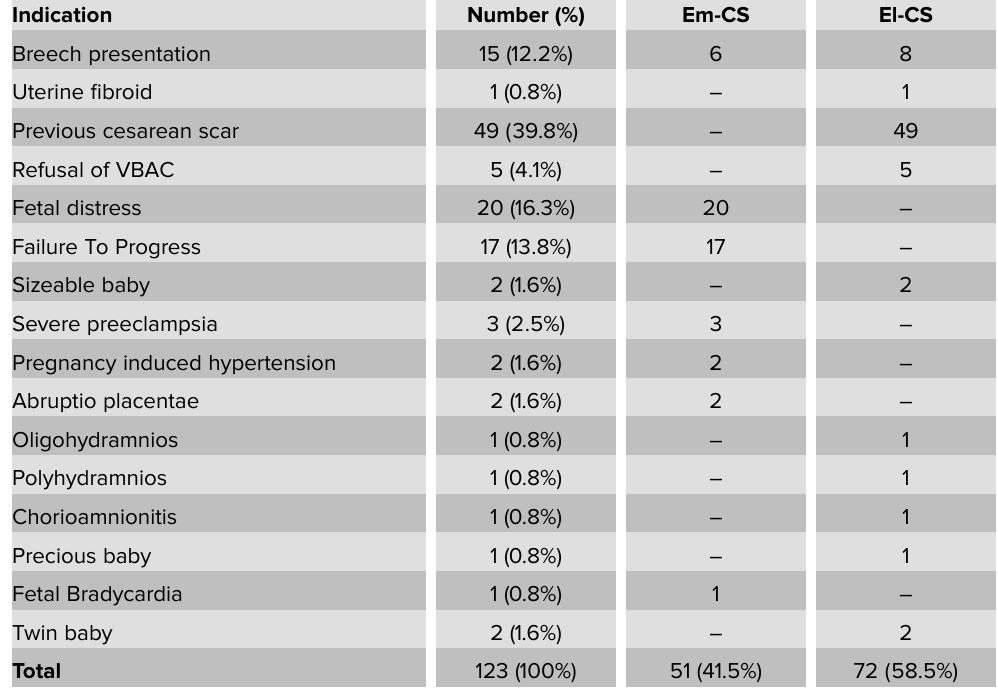
TABLE 2: Different indications for emergency (Em-CS) and elective cesarean section (El-CS) ( n = 123) Indication